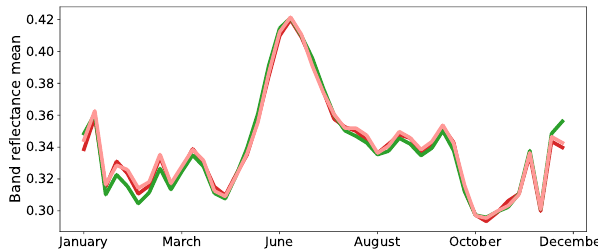
Figure 8. Average reflectances of the training samples belonging to temp. meadows, perm. meadows and fodder; the most confused classes according to Figure 7.